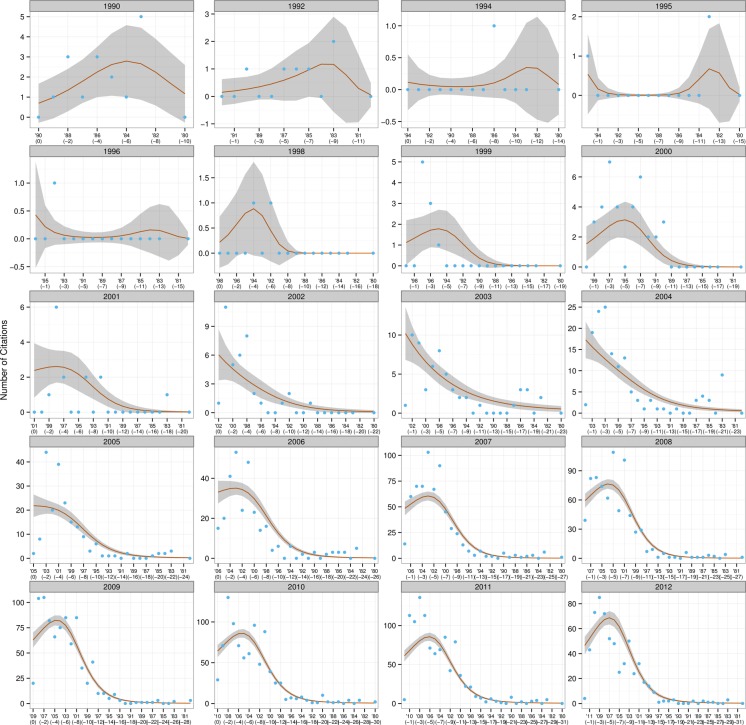
Trends in citations for research papers.